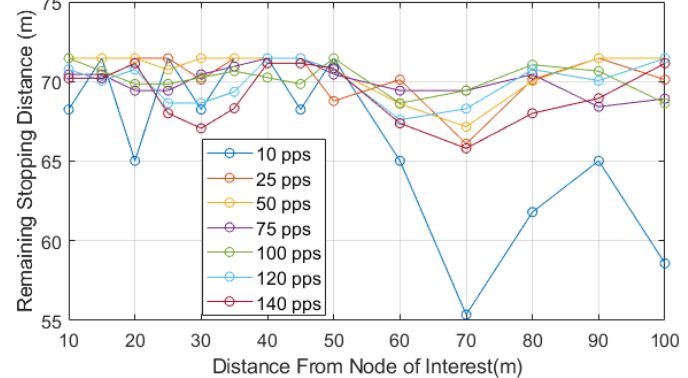
Figure 11. Seventy miles per hour (112.63 km/h) distance dependent reduction in stopping